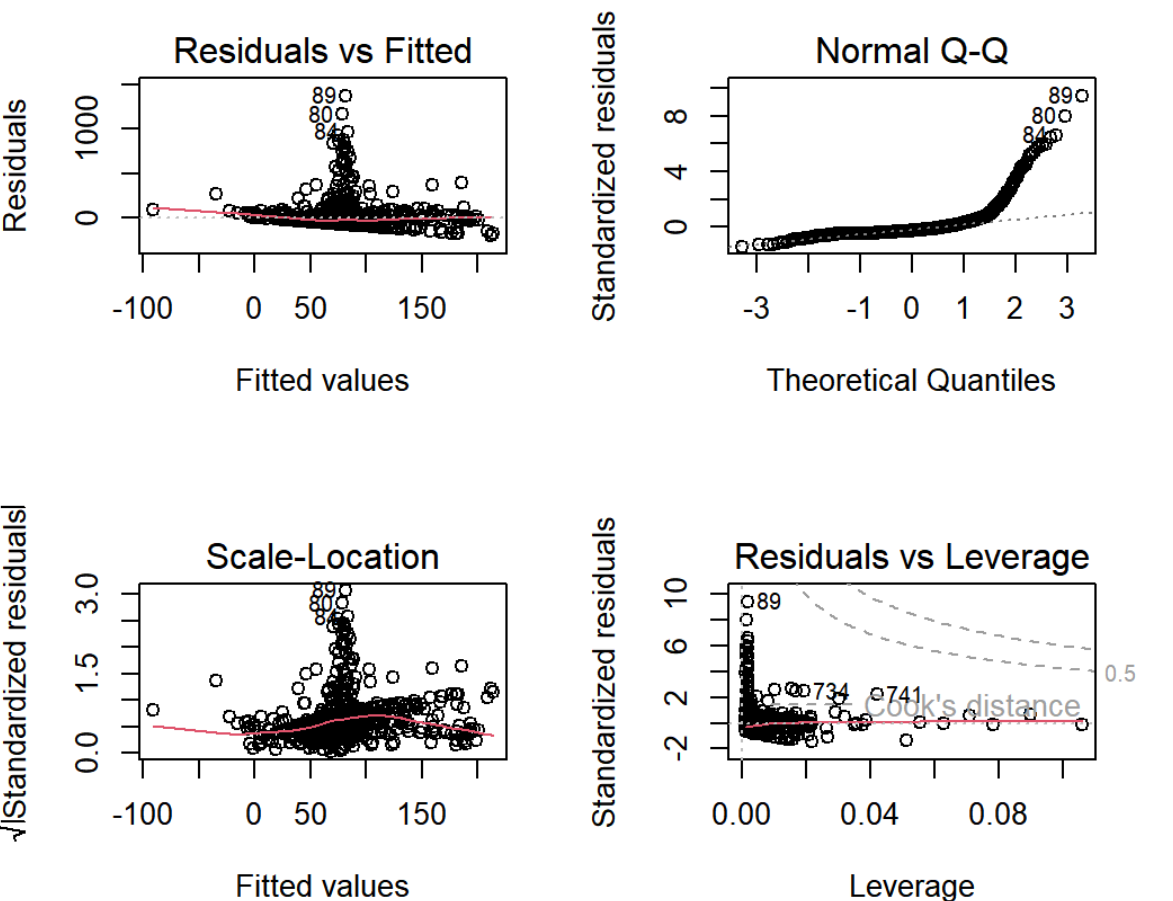
Figure 5. Plots of linear regression for NY with CA, TX, FL cumulative daily COVID-19